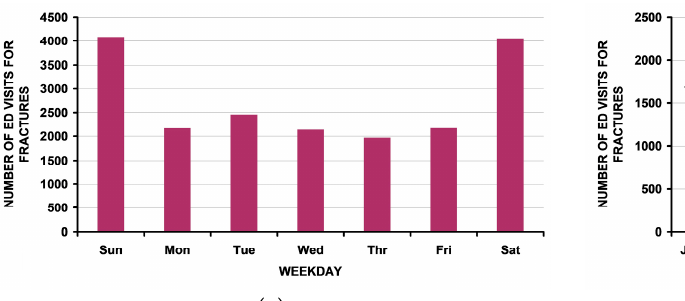
Figure 6. Differences in age group by incident locale ( p = 0.037). Note the decreasing number of cases occurring at home with increasing age.